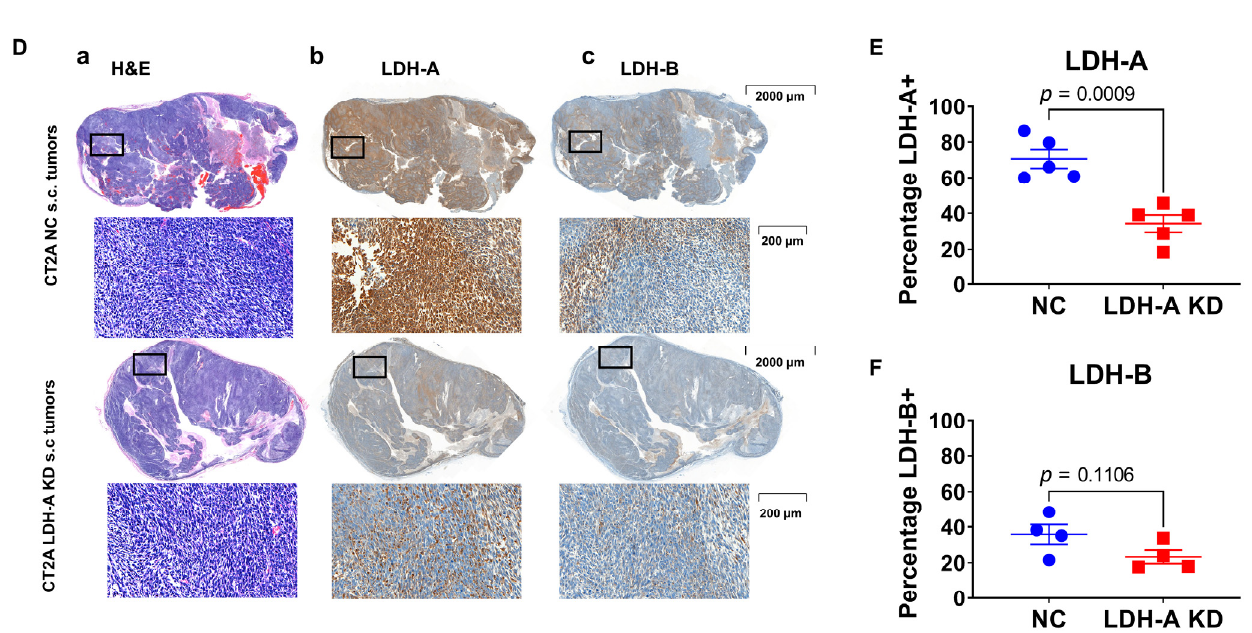
Figure 7. H&E and IHC staining for LDH-A and LDH-B protein expression in s.c. GL261 and CT2A tumors—both LDH-A KD and NC controls . H&E staining for GL261 NC and LDH-A KD tumors ( Aa ); LDH-A staining ( Ab ) and LDH-B staining ( Ac ). GL261 NC and LDH-A KD tumors were grown in immunocompromised nude mice. Quantification of percentage LDH-A tumor expression ( B ) and percentage LDH-B tumor expression ( C ); ± SEM. A similar presentation is shown for CT2A tumors, grown in immune-competent C57BL/6 mice (Panels D – F ). In many, but not all, GL261 tumor regions, there was an inverse relationship between LDH-A and LDH-B expression intensity (Figures S2A and S3A). This inverse relationship was greater for LDH-A KD than NC GL261 tumors (Figure S3A). CT2A tumors showed a different relationship; there was a more direct relationship between LDH-A and LDH-B expression intensity (Figures S2B and